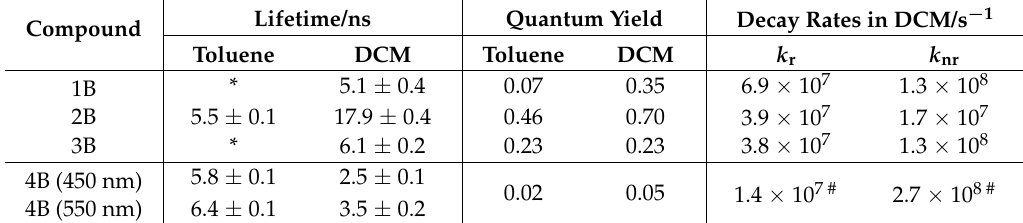
Table 4. Excited state lifetimes, as measure by photon counting, and quantum yields for the set B compounds, in toluene and DCM. Alongside calculated radiative and non-radiative decay rates. Compound